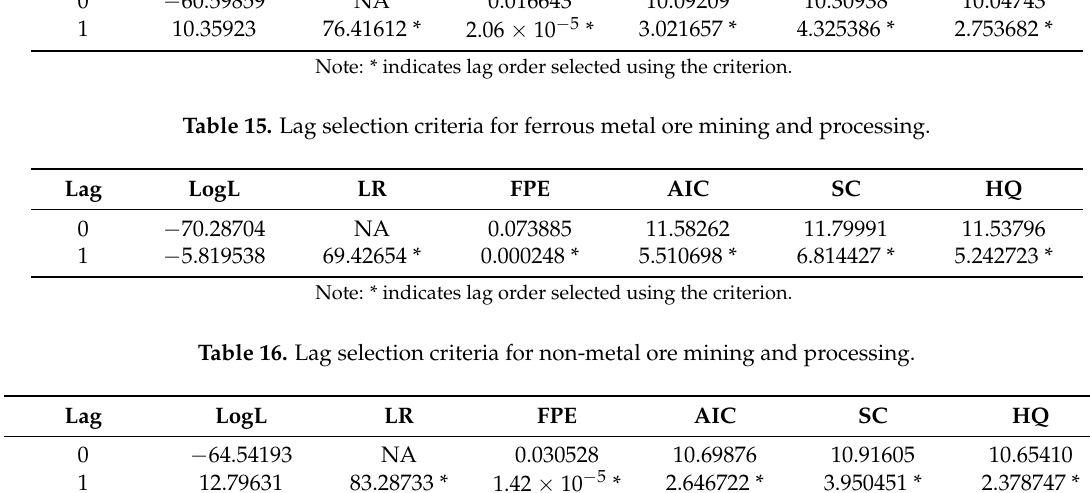
Table 14. Lag selection criteria for non-ferrous metal ore mining and processing. Lag LogL